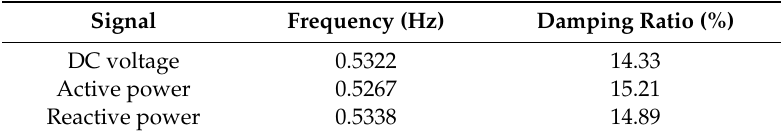
Table 5. Oscillation parameters of GVSC port variables.